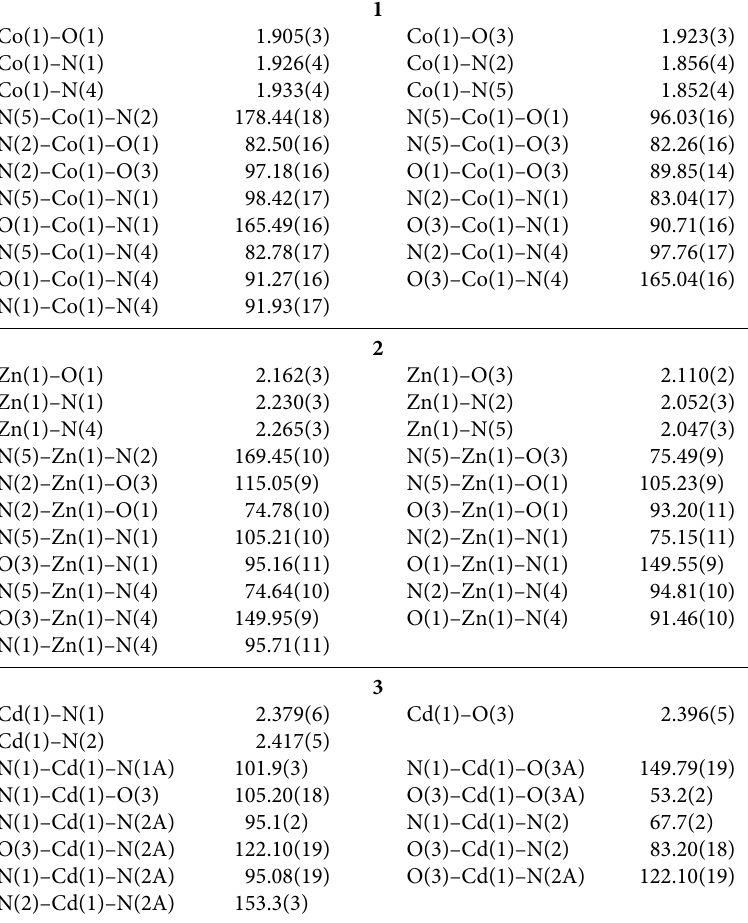
Table 2. Selected bond distances (Å) and angles (°) for the complexes